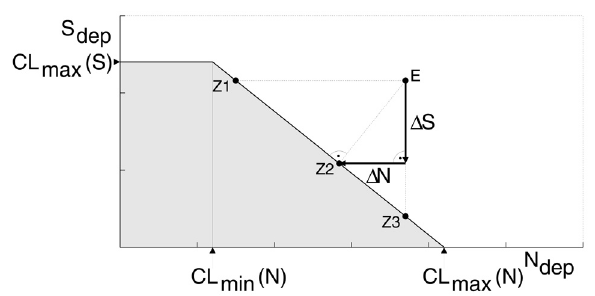
FIGURE 1. Example of a critical load function for acidifying nitrogen and sulfur defined by the three quantities CL area below the function represents depositions of N and S for which there is nonexceedance of acidity-critical loads. Also indicated is the way in which the exceedance (AAE) is calculated (see below).